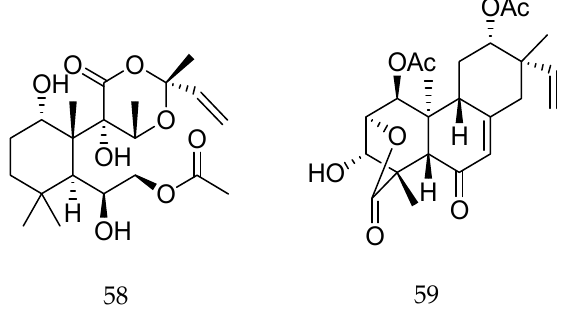
Figure 25. Chemical structures of diterpenes 58 and 59 [109,110]. Molecules 2018 , 23 , x